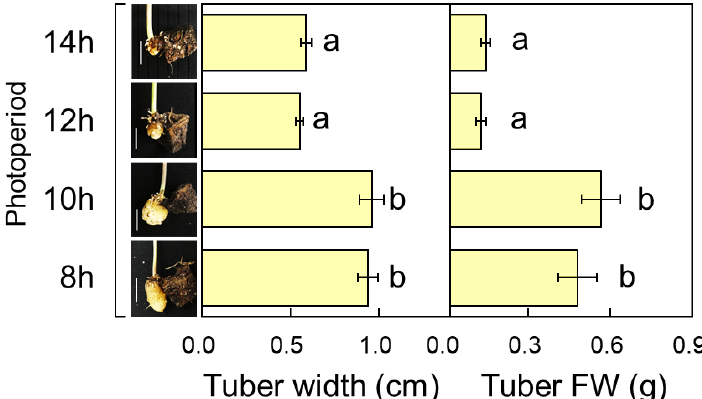
Figure 1. Responses of tuber width and fresh weight (FW) to photoperiod. Plants were grown under 14, 12, 10, or 8 h photoperiod in a biotron at 30 °C for 40 days. Values are means ± SD of 14 – 17 replicates derived from different plants. Bars followed by the same letter are not significantly different by Tukey’s test at the 5% level. Scale bars, 1 cm.